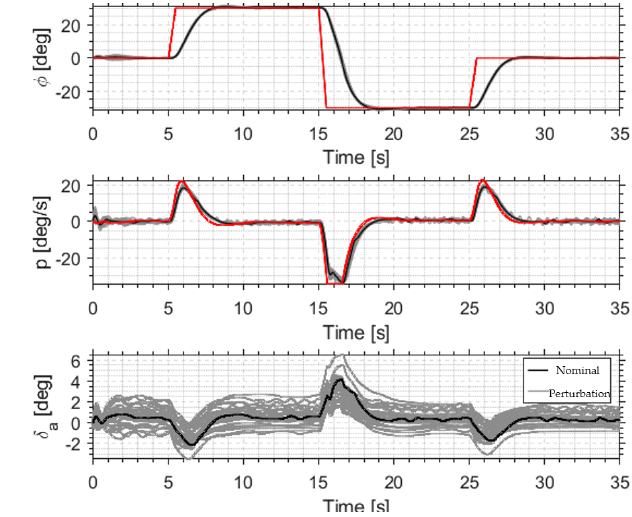
Figure 18. Perturbation simulation of the roll channel at 1 km altitude and 0.2 Mach number.